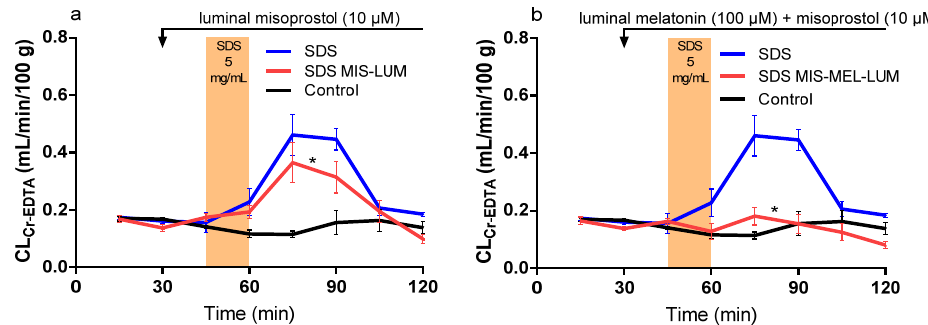
Figure 3. The blood-to-lumen CL Cr-EDTA between 0 and 120 min for the control buffer solution with or without SDS at 5 mg/mL added to the luminal perfusate between 45 and 60 min. ( a ) The effect of luminally treating rats with misoprostol (10 μ M) between 30 and 120 min in the SDS experiment. ( b ) The effect of luminally treating rats with melatonin (100 μ M) and misoprostol (10 μ M) between 30 and 120 min in the SDS experiment. The * represents a significant decrease in CL Cr-EDTA exposure of the luminal drug treatments compared to SDS alone.